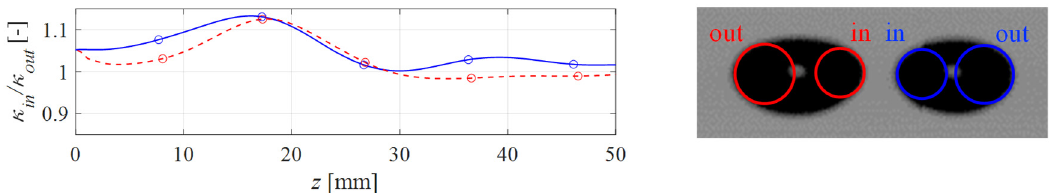
Figure 5. Curvature ratio between inside and outside the gap. Solid line: B1; dashed line: B2; symbol “o”: curvature ratio every 50 ms.